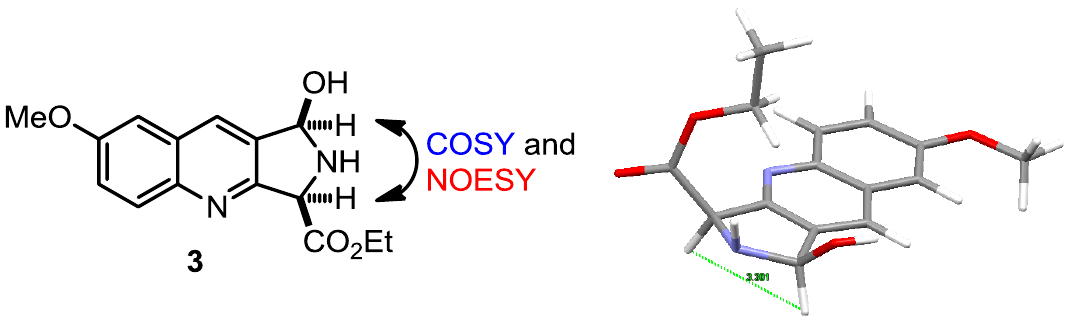
Figure 1. Assignment of the relative configuration of 3 based on 2D NMR data and a modelled 3D structure (free base